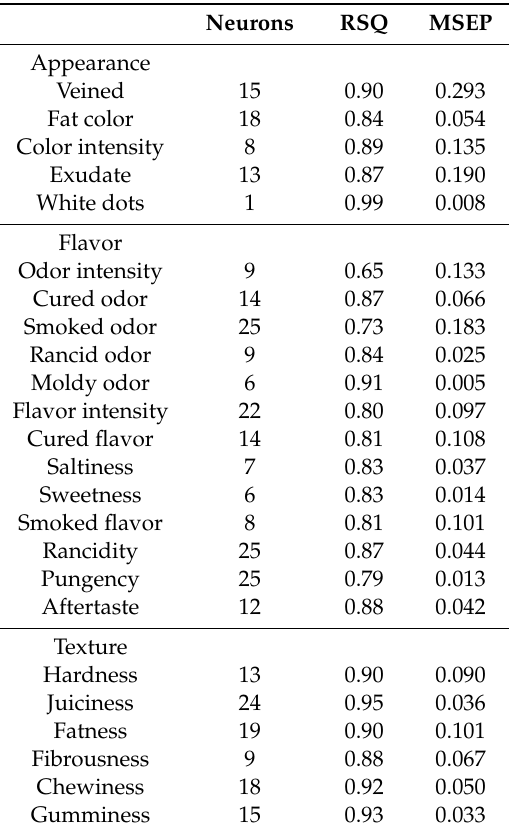
Table 4. The number of neurons in the hidden layer, correlation coe ffi cient R squared (RSQ), and mean square error or prediction (MSEP) of the best ANN for each sensory